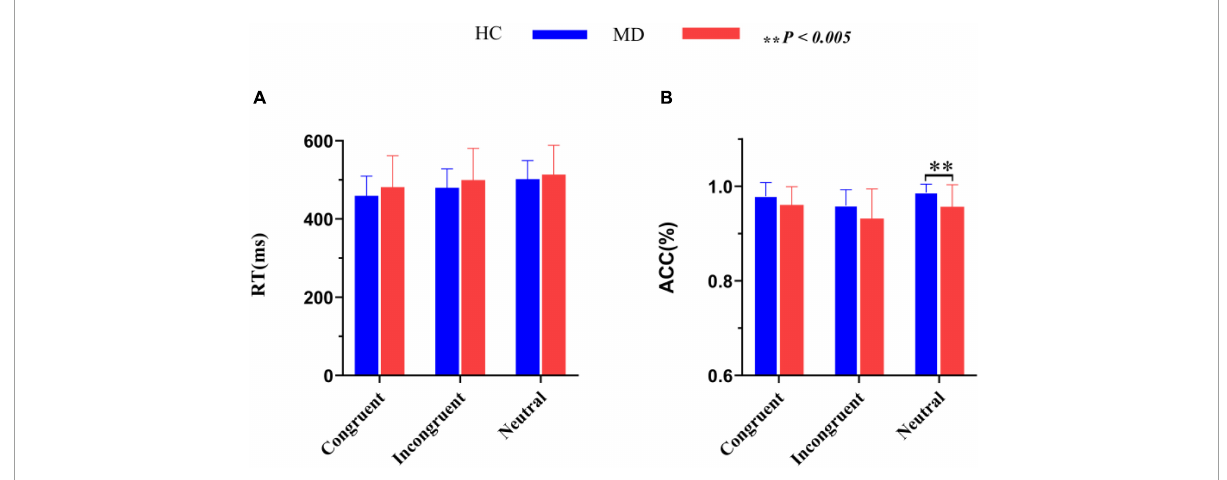
FIGURE3 Comparisons of RT (A) and ACC (B) between the MD group and HC group. MD, major depression group; HC, healthy control group; RT, reaction time; ACC, accuracy rate (percent of correct responses/hits). ∗∗ P <